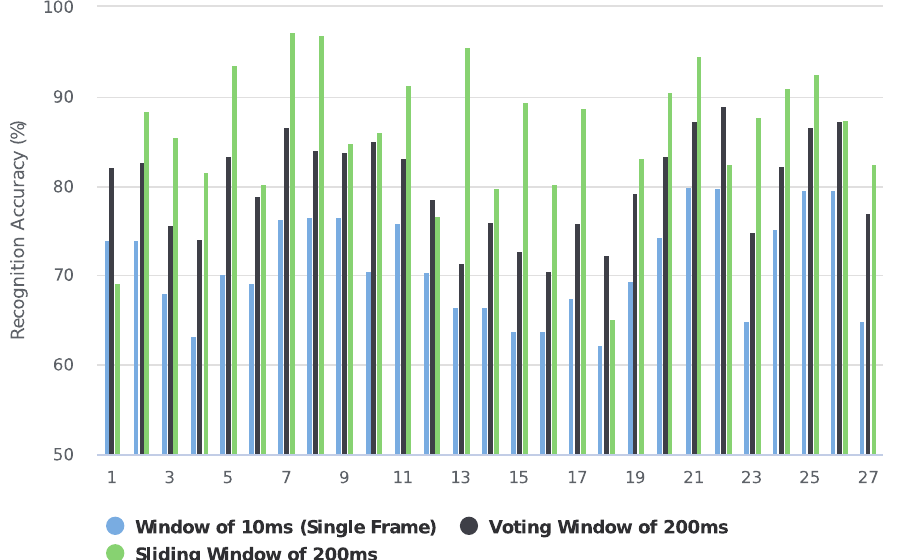
Figure 8. Recognition performances of 27 subjects when using single frame of 10 ms, voting time window of 200 ms, and sliding time window of 200 ms in NinaPro DB1.